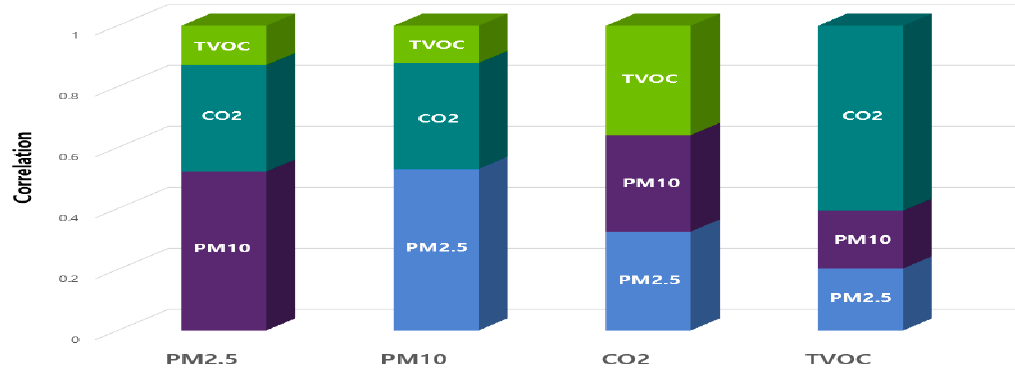
Figure 9. Correlation results of graph in smoking situations.